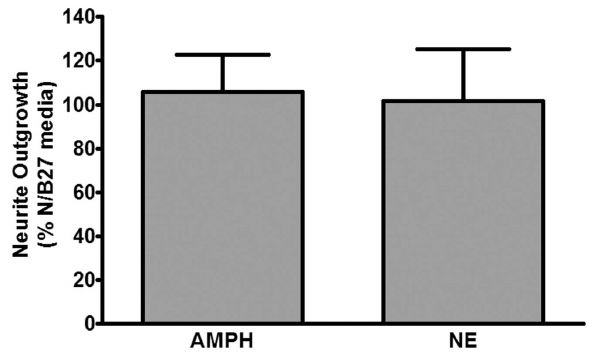
Figure 4. Direct treatment of primary cortical neurons with amphetamine or norepinephrine for 24 hr has no effect on neurite outgrowth. Cortices from E18 rats were dissociated and plated on 12 mm poly-lysine-coated coverslips and allowed to equilibrate as described in Methods. Amphetamine (10 uM), norepi- nephrine (10 uM) or vehicle was added and incubated with neurons for 24 hr. Neurons on coverslips were fixed and stained for MAP2 and analyzed for neurite outgrowth as described in Methods. Data represent the mean 6 SEM of 5 independent observations.